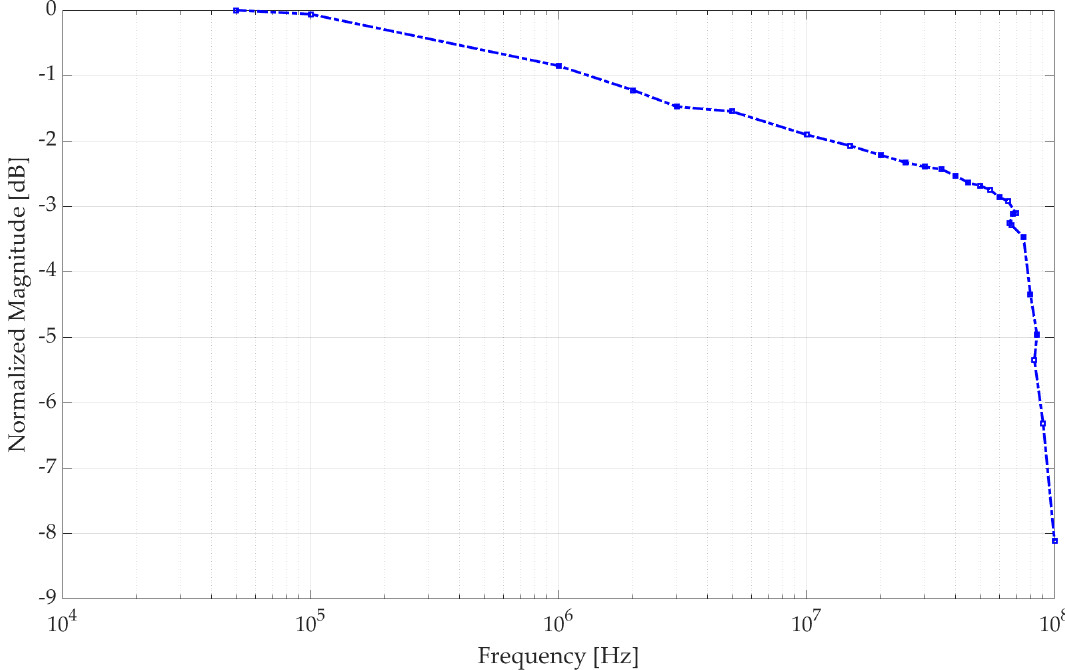
Figure 7. Frequency response of the laser driver.